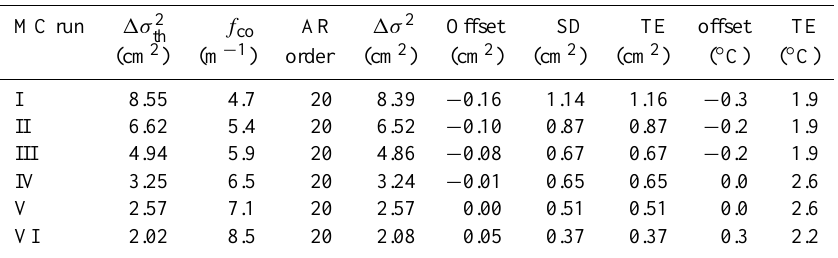
Table 2. The optimum parameters and the resulting mean values, deviations from theoretical values and SDs for the differential diffusion lengths of the Monte Carlo runs obtained with the PSD method for 5cm samples. TE is the total error as described in the main text. The total error and the offsets from the real values are also converted to the corresponding errors in firn temperature for each run.